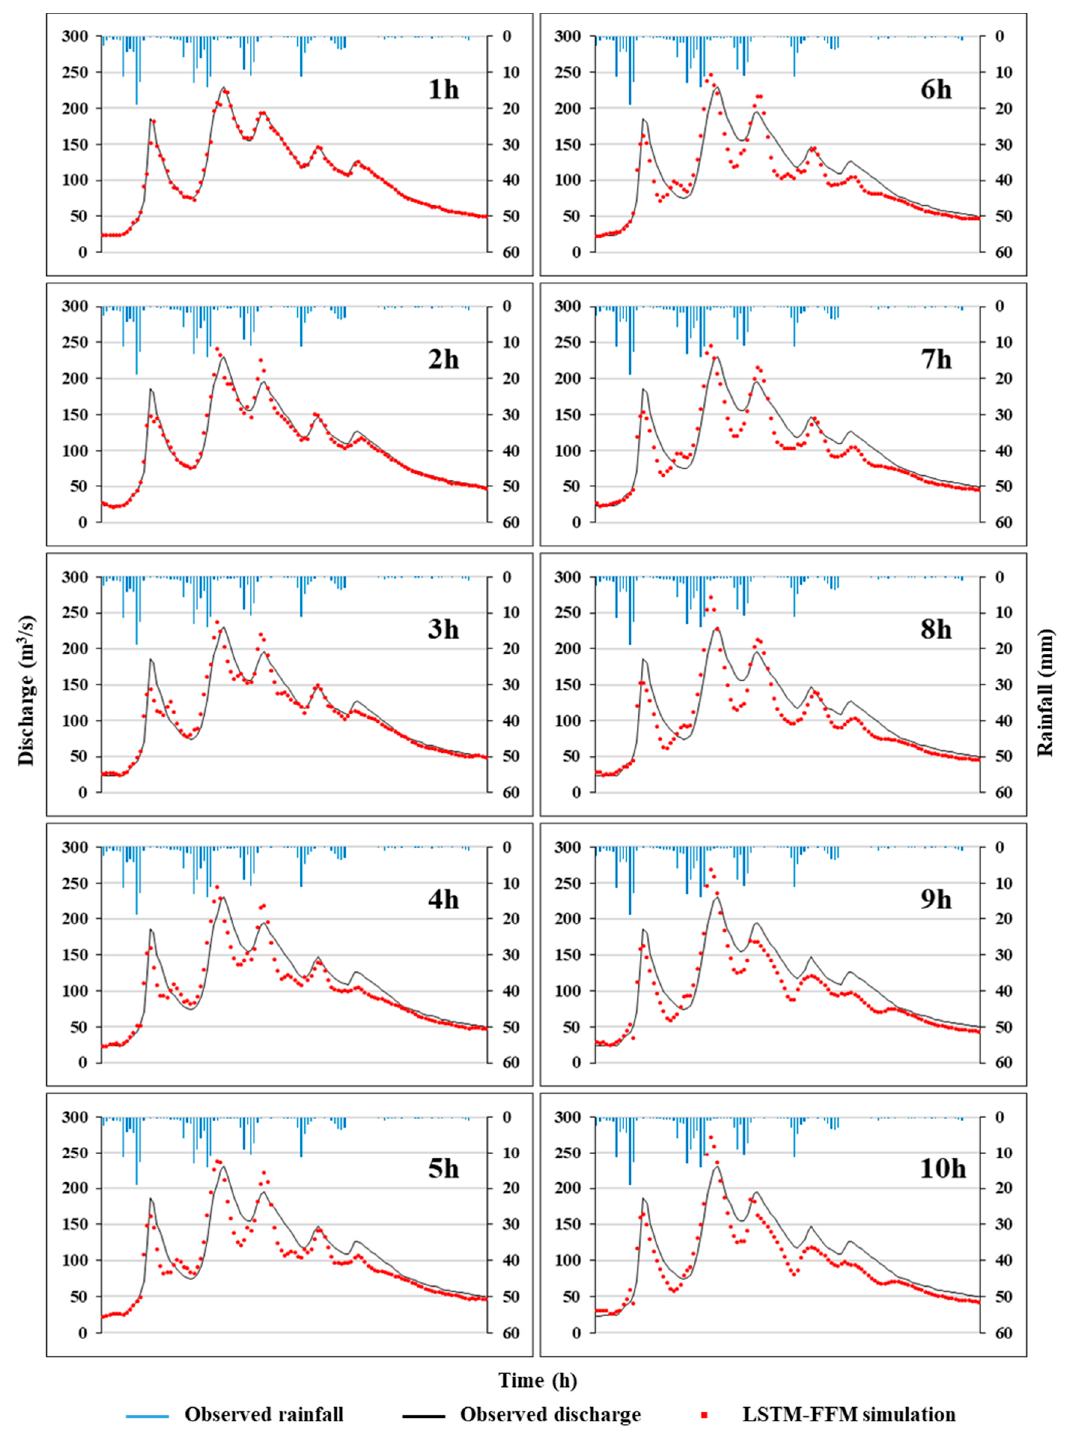
Figure 9. Observed and simulated discharge of 20120622 flood event.